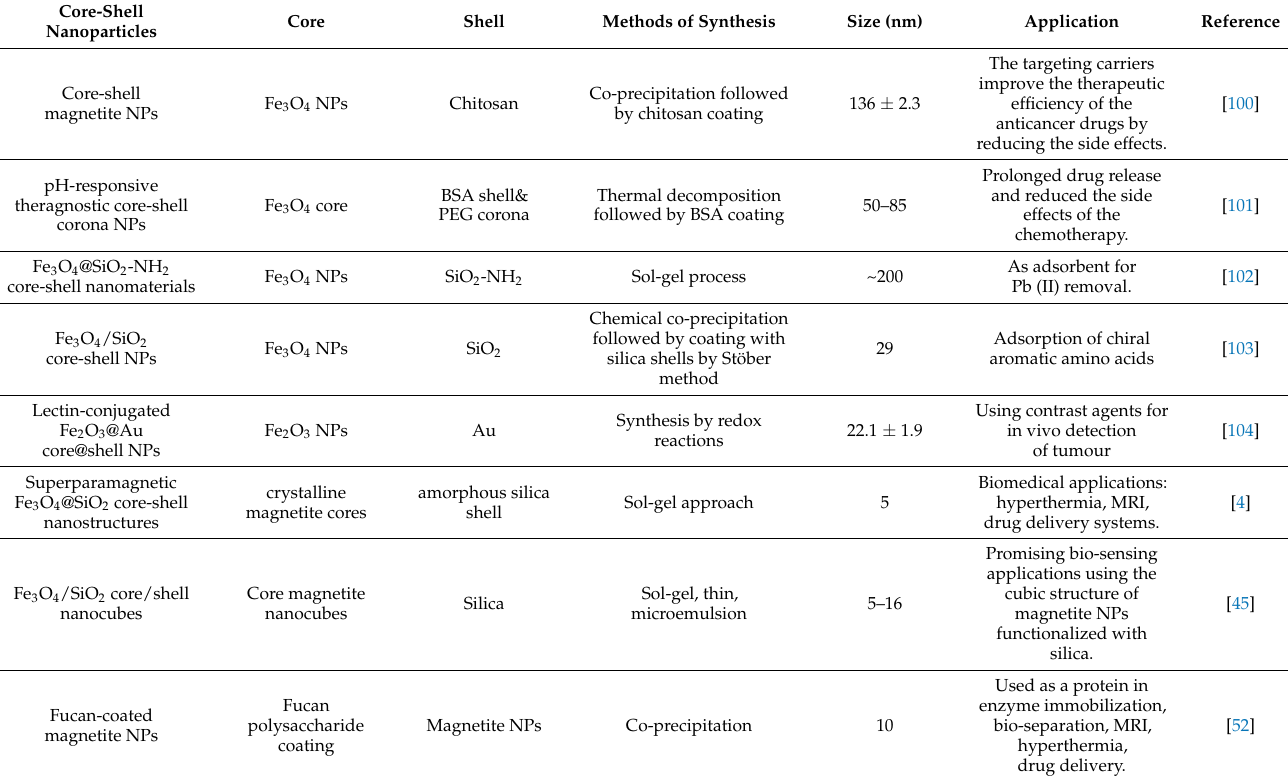
Table 1. Various core/shell nanoparticles and their synthesis methods and applications [4]. Core-Shell